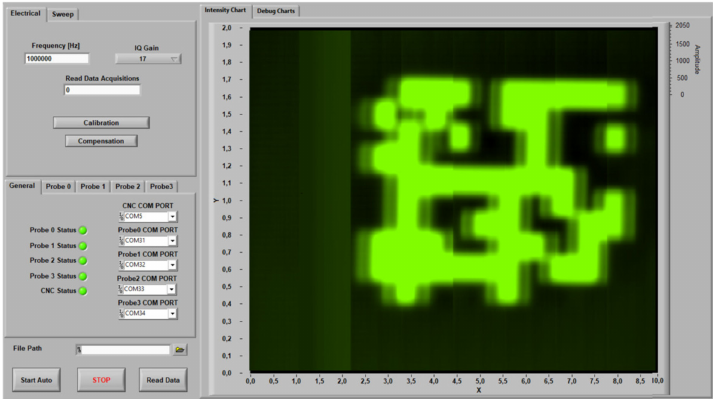
Figure 14. LabVIEW GUI computer application.